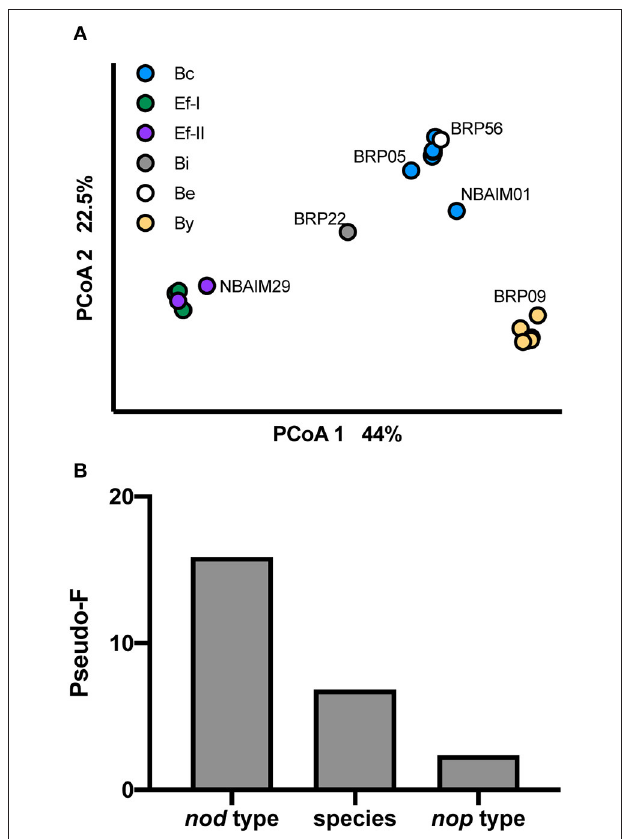
FIGURE 9 | Population structure. (A) PCoA representing pigeon pea population and shown with visual separation by nod type. (B) Influence of different factors on pigeon pea endosymbiont population using PERMANOVA. Pseudo-F value as a proxy. N =